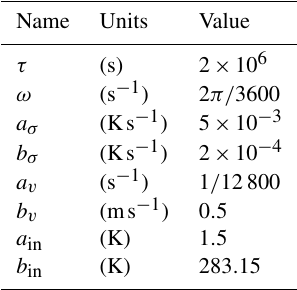
Table 6. Values chosen for the parameters of test cases 1 and 2, and used to validate the numerical splitting scheme presented in Sect. 2.2.2.